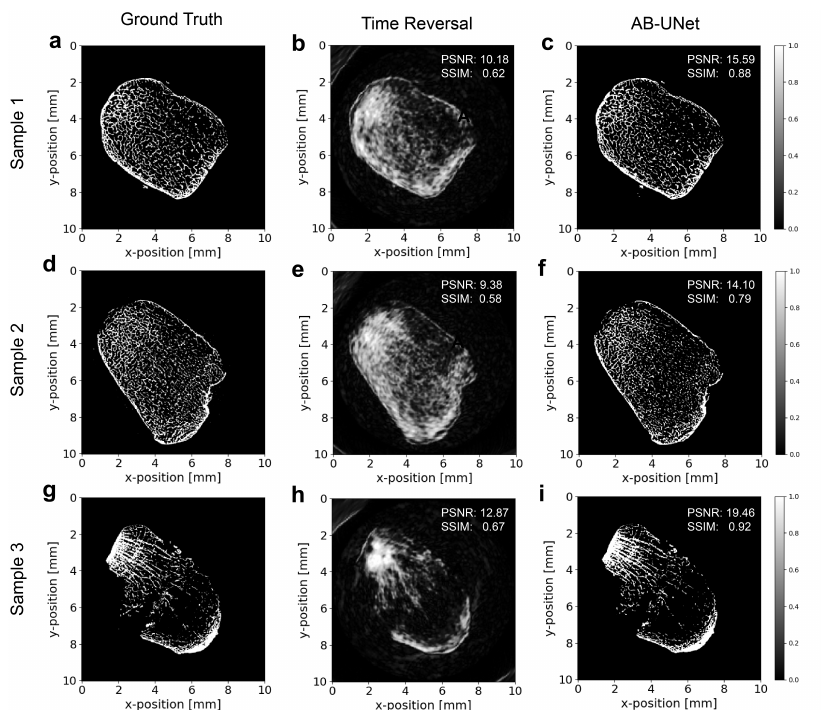
Figure 4. ( a – i ) Visual comparison of the performance in three examples based on TR and AB-U-Net. Each row represents a different bone sample, from top to bottom: sample 1, sample 2 and sample 3. Every column represents different method, from left to right: ground truth, time-reversal reconstructed and AB-U-Net.